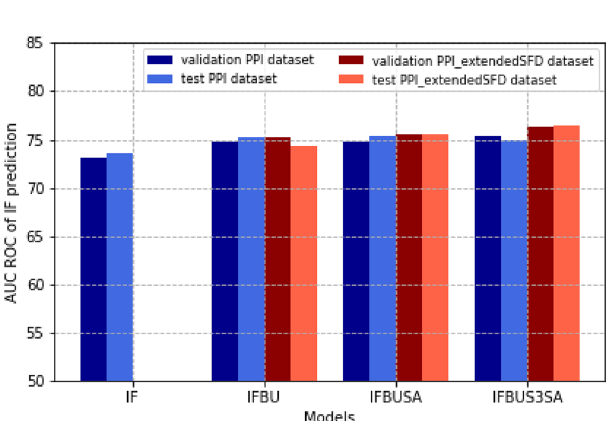
Figure 3. Comparison of the single-task model and multi-task models based on the AUC ROC scores of the PPI interface prediction on the validation and an independent test set. Performances are shown for the validation (dark blue) and test (blue) set for models trained on the PPI dataset, and the validation (dark red) and test (red) set for models trained on the PPI_extendedSFD dataset. All models are trained once on the training set. Similar performances are shown for the validation and test set. The multi-task models outperform the single-task